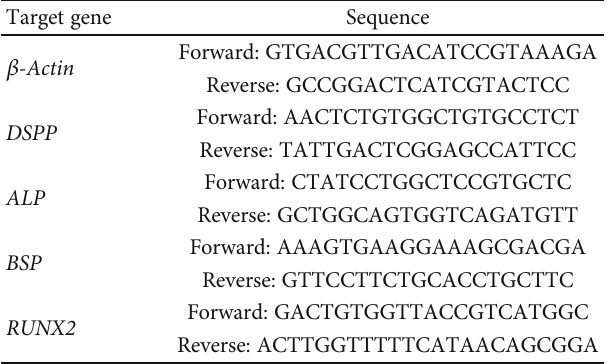
Table 1: Primers used for real-time PCR. Target gene